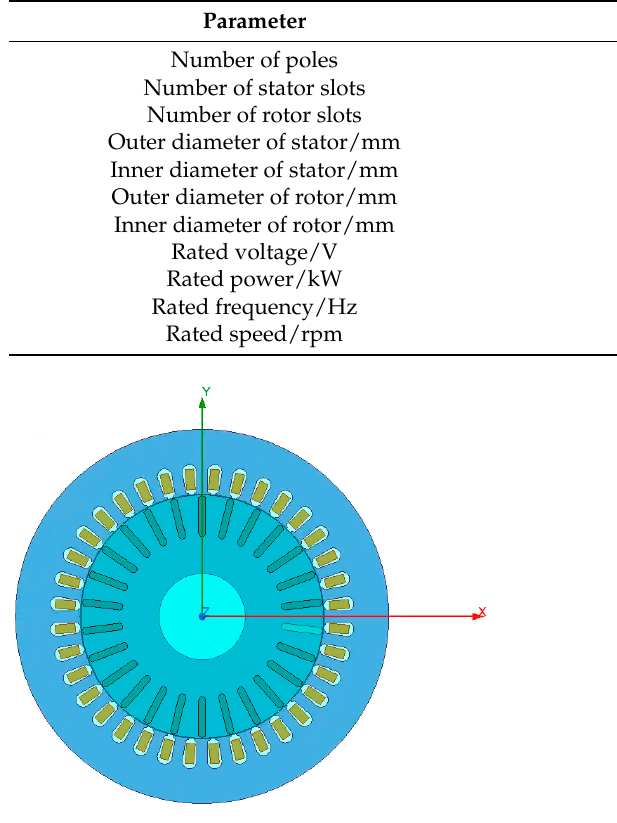
Figure 1. The finite element simulation model of submersible motor.